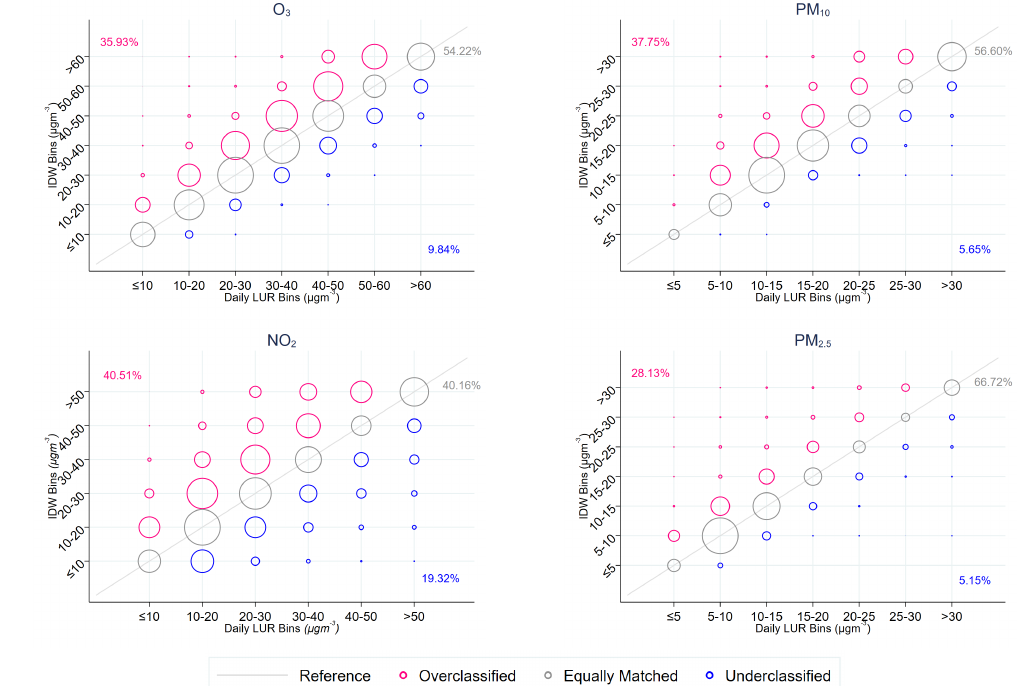
Figure 3. Scatter graphs comparing the number of visits classified to air pollution bins, defined using IDW and daily LUR techniques. Pollution concentrations are across four pollutants: NO 2 , O 3 , PM 10 , and PM 2.5 . The size of the circle represents the number of visits. The percentage (%) match of air pollution indicator bins derived by IDW compared to air pollution indicator bins derived daily LUR estimates. A misclassified overestimated group is when IDW-estimated exposure is classified to be larger than those classified by daily LUR-estimated exposure. A misclassified underestimated group is when IDW exposure is classified to be smaller than those classified by the daily LUR-estimated